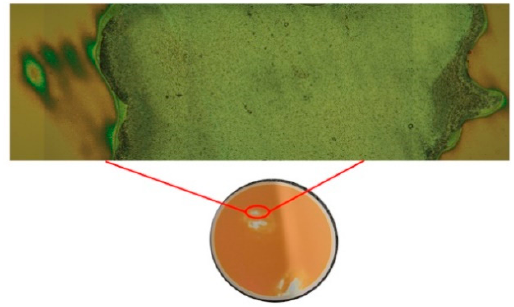
Figure 7. Damage phenomenon of the Si window with short-pulse laser irradiation .